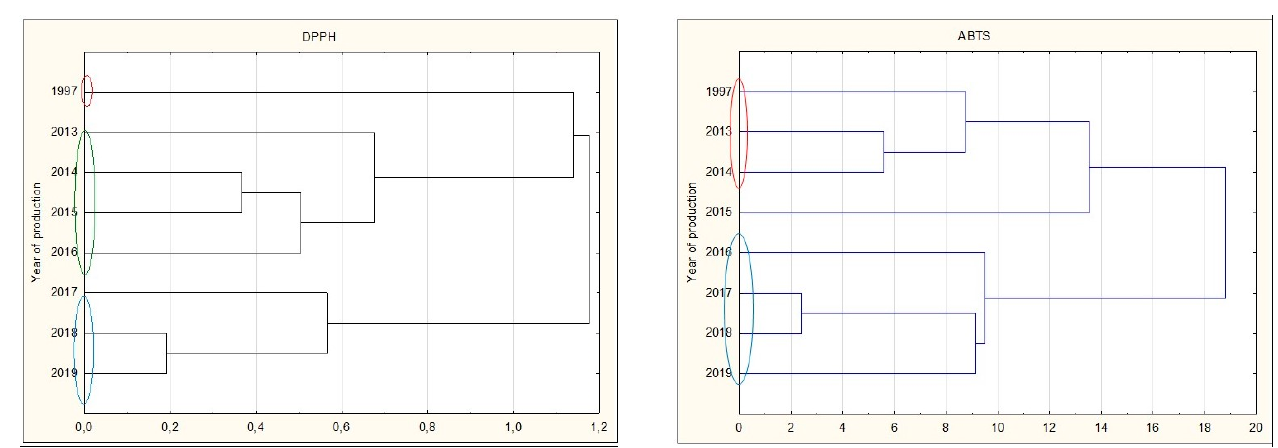
Figure 6. The tannin content of nalewkas (mean ± SD, n = 3). Different letters indicate significant differences between the nalewkas in individual years of production ( α = 0.05). The result was expressed in mg tannin · mL − 1 of nalewka.